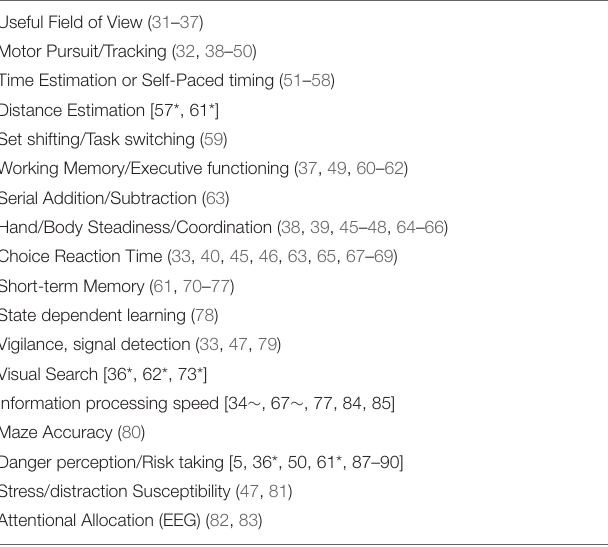
TABLE 1 | Cannabis impairment effects on driving-related cognitive tasks.